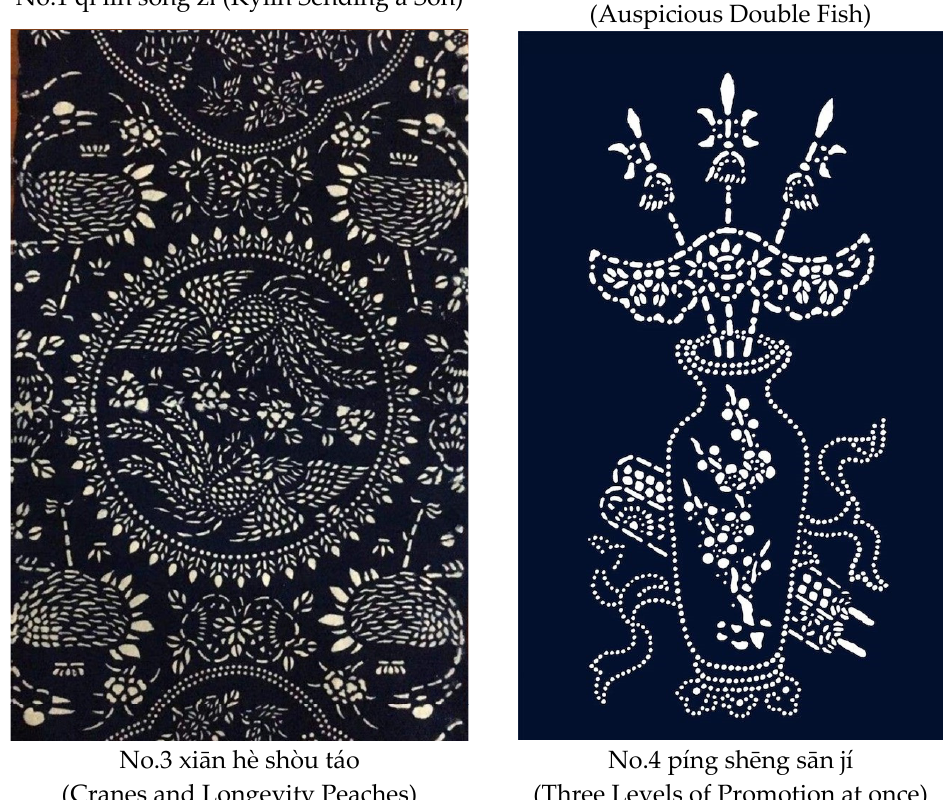
Figure 1. Photographs of the four blue calicos and their names. Three video clips of information required for the experiment—the product name, art- ist’s comments, and the production process—were obtained from the official website [63,64]. The name of each blue calico is introduced in the first video. Mr. Wu Yuanxin, a master of Chinese arts and crafts, comments on blue calico in the second video. The pro- cess of making blue calico is shown in the third video.